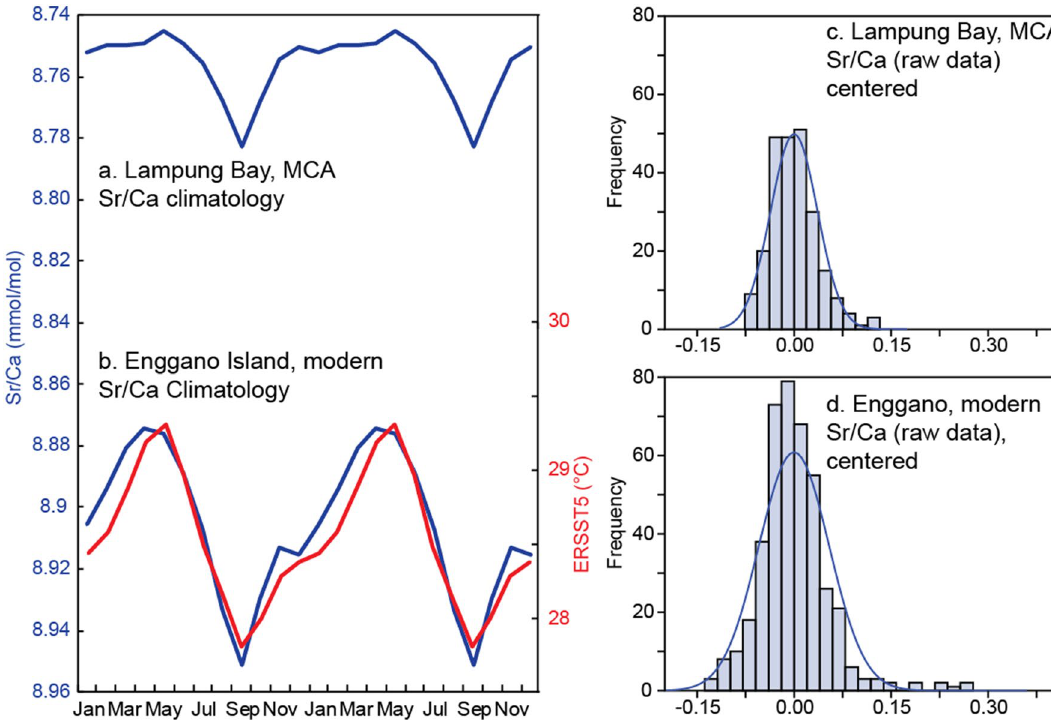
Figure 5. Seasonality and skewness of modern and MCA coral Sr/Ca data. ( a ) Climatological Sr/Ca data calculated from the monthly record from Lampung Bay (LAM). ( b ) Same as ( a ), but calculated from the modern record from Enggano Island (blue line). Red line shows ERSST5 climatology for comparison. ( c ) Histogram of Lampung bay Sr/Ca (raw data) and ( d ) histogram of Enggano Island Sr/Ca (raw data, centred by removing its mean). Note the skewness of the Enggano data that reflects the pronounced cooling during extreme positive IOD events (see Table 3 for basic